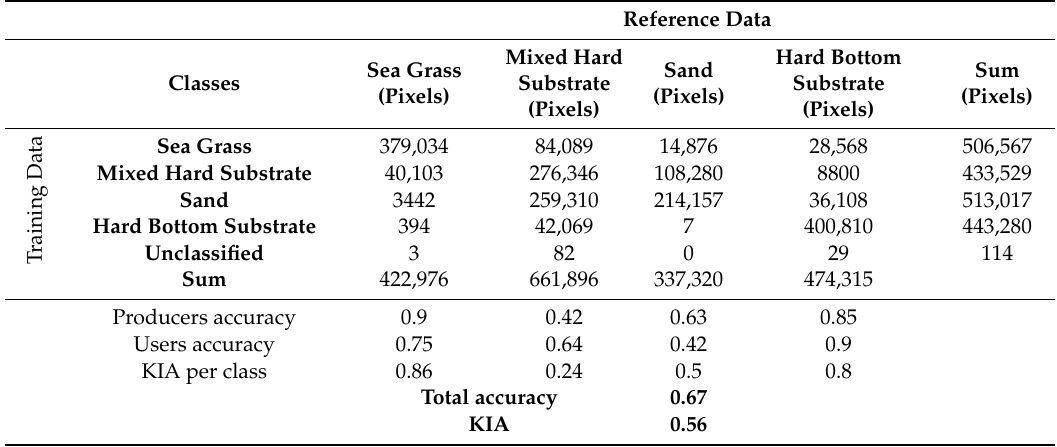
Table 8. The tc-RGB data classification accuracy matrix for the multispectral orthomosaic.